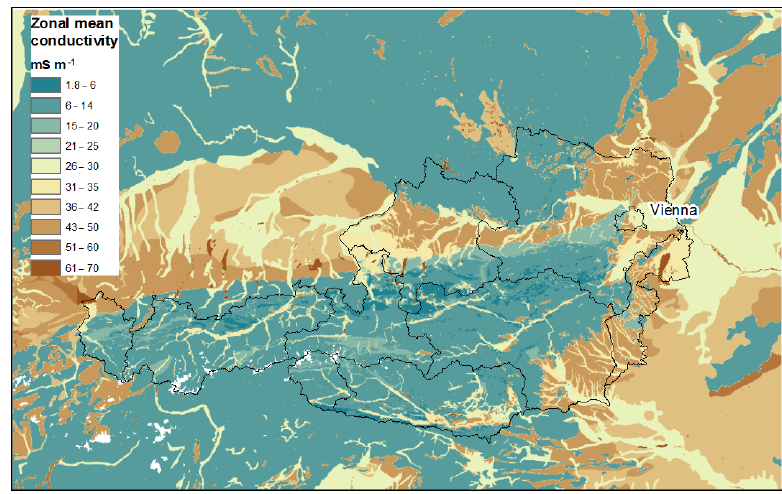
Figure 1. High-resolution subsurface conductivity model of Austria and its surroundings produced by the GBA.